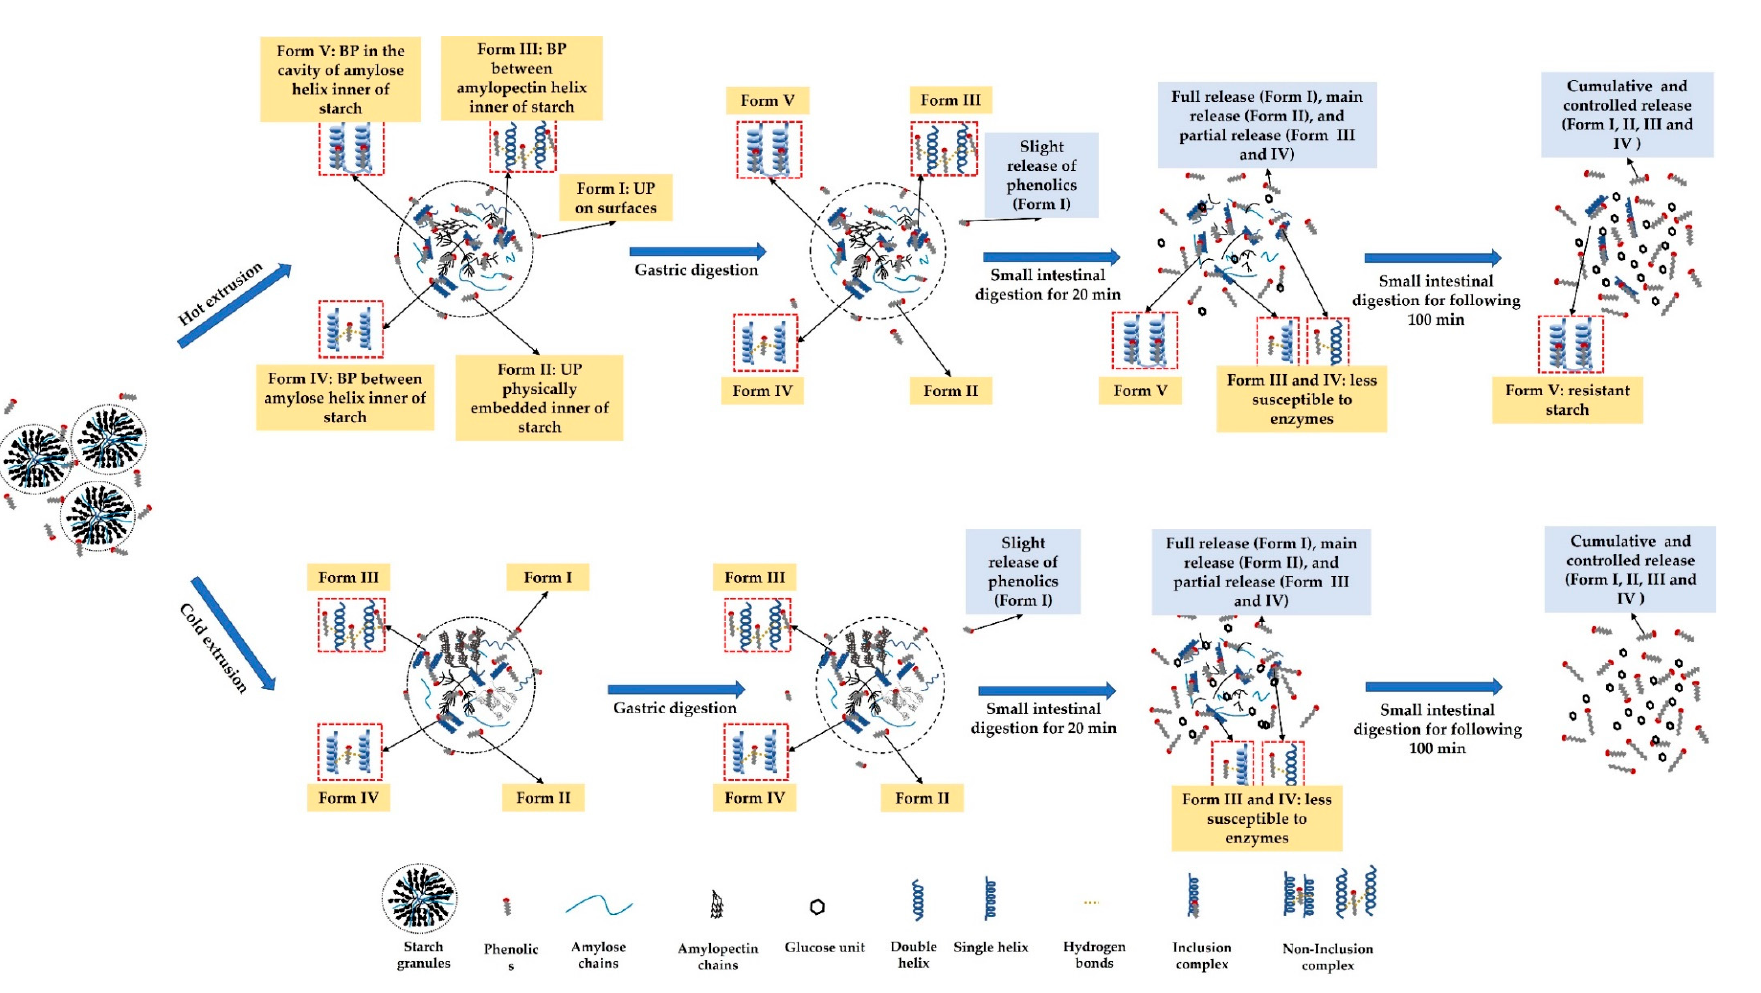
Figure 4. Possible releasing mechanism of unbound and bound phenolics from the extruded noodles during simulated in vitro gastrointestinal digestion